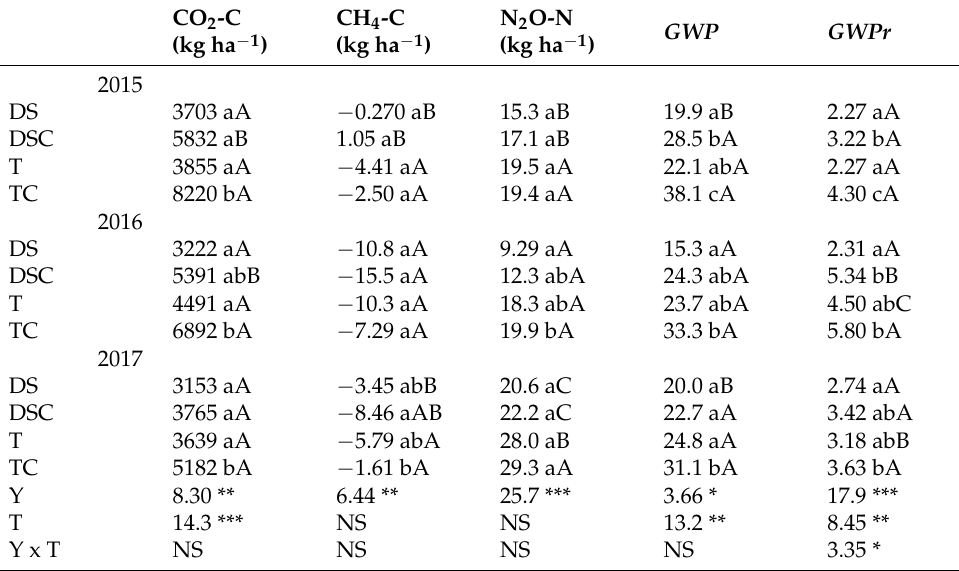
Table 1. Effect of the different management systems on the cumulative emissions of CO 2 -C, CH 4 -C, and N 2 O-N (kg ha − 1 ) during the rice cultivation cycle. CO 2 -C CH 4 -C N 2 O-N GWP (kg ha − 1 ) (kg ha − 1 ) (kg ha − 1 )